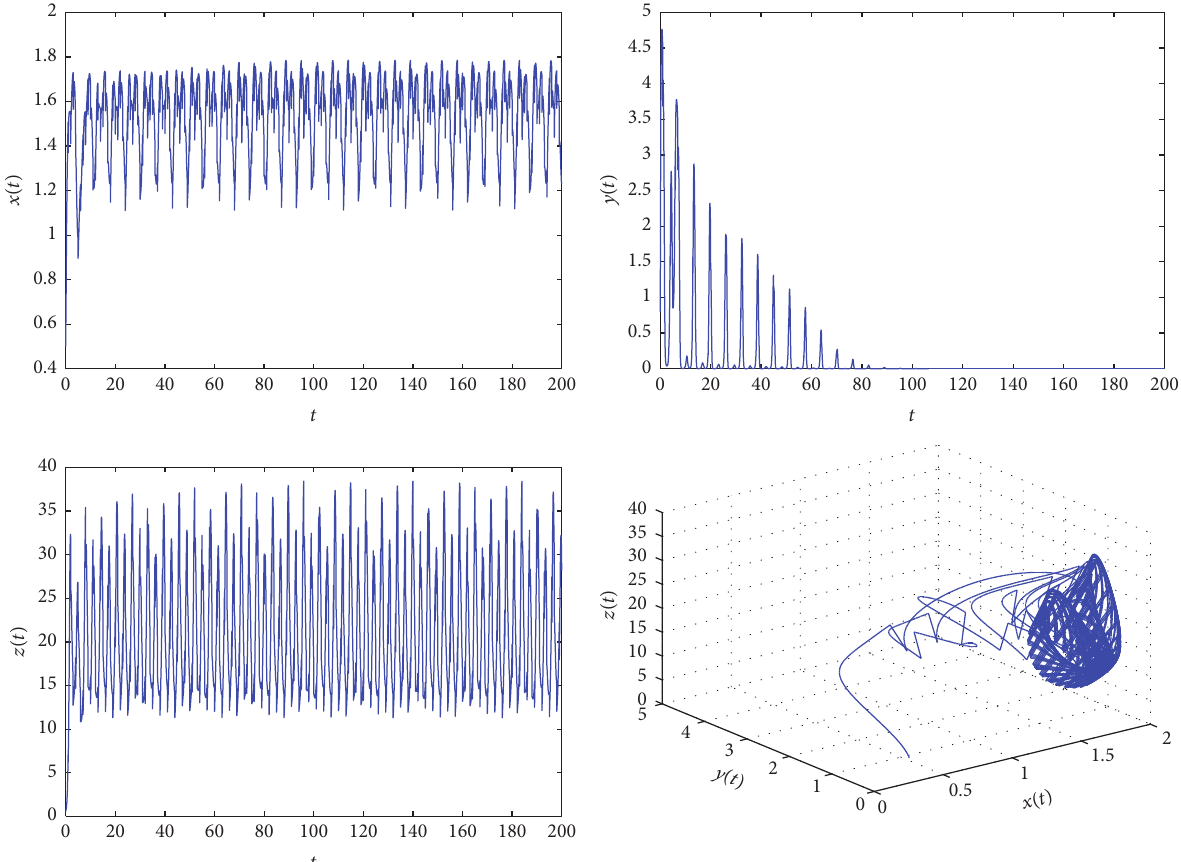
Figure 4: Extinction of the lower predator of system (1) with 𝜙 1 (𝑠) = 𝑥(0) = 0.5 , 𝜙 2 (𝑠) = 𝑦(0) = 0.8 , 𝜙 3 (𝑠) = 𝑧(0) = 0.6 , 𝑠 ∈